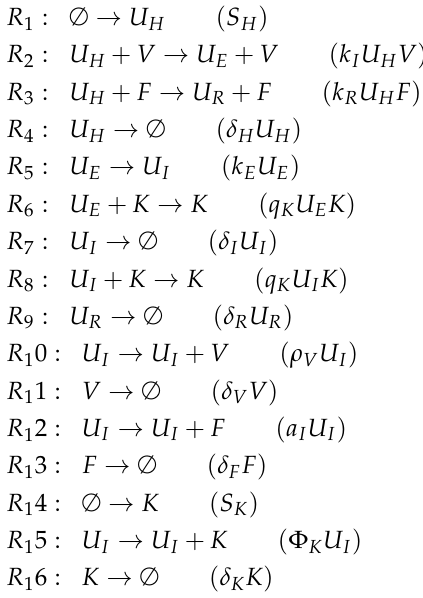
Figure A6. Reactions of Hernandez model [26].